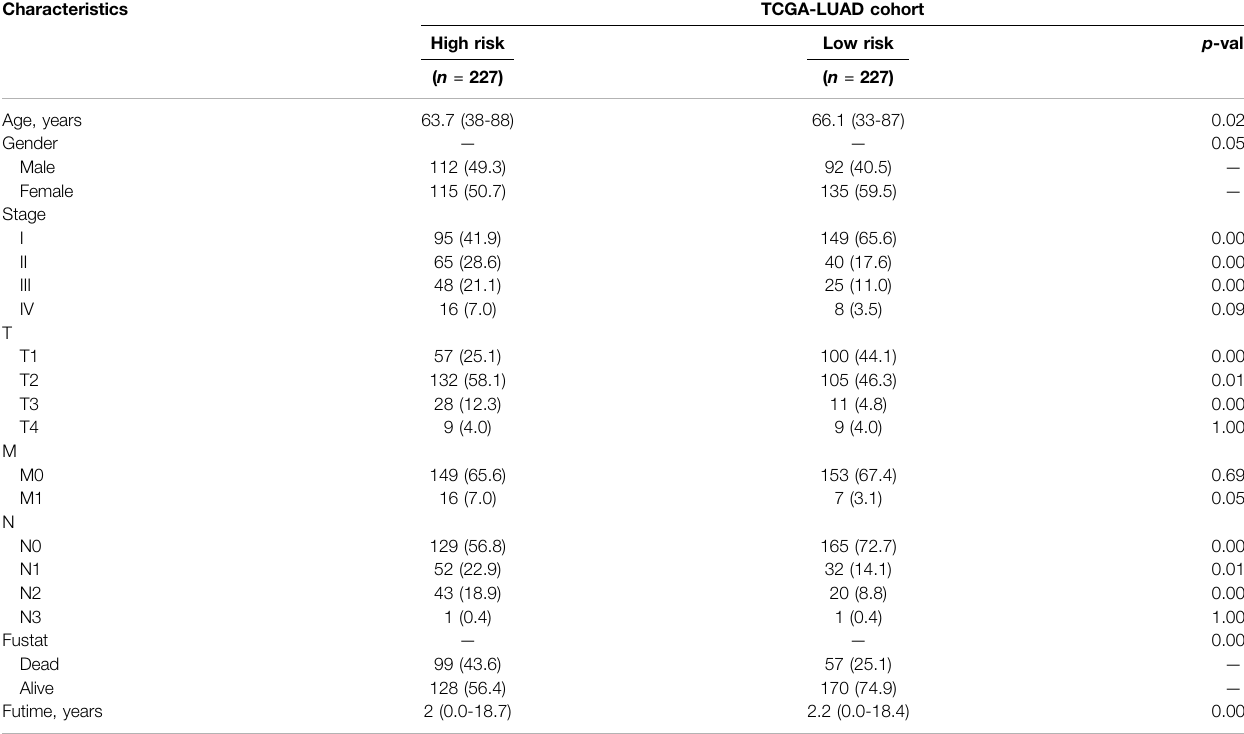
TABLE 1 | Characteristics of two risk group patients in TCGA LUAD cohort.